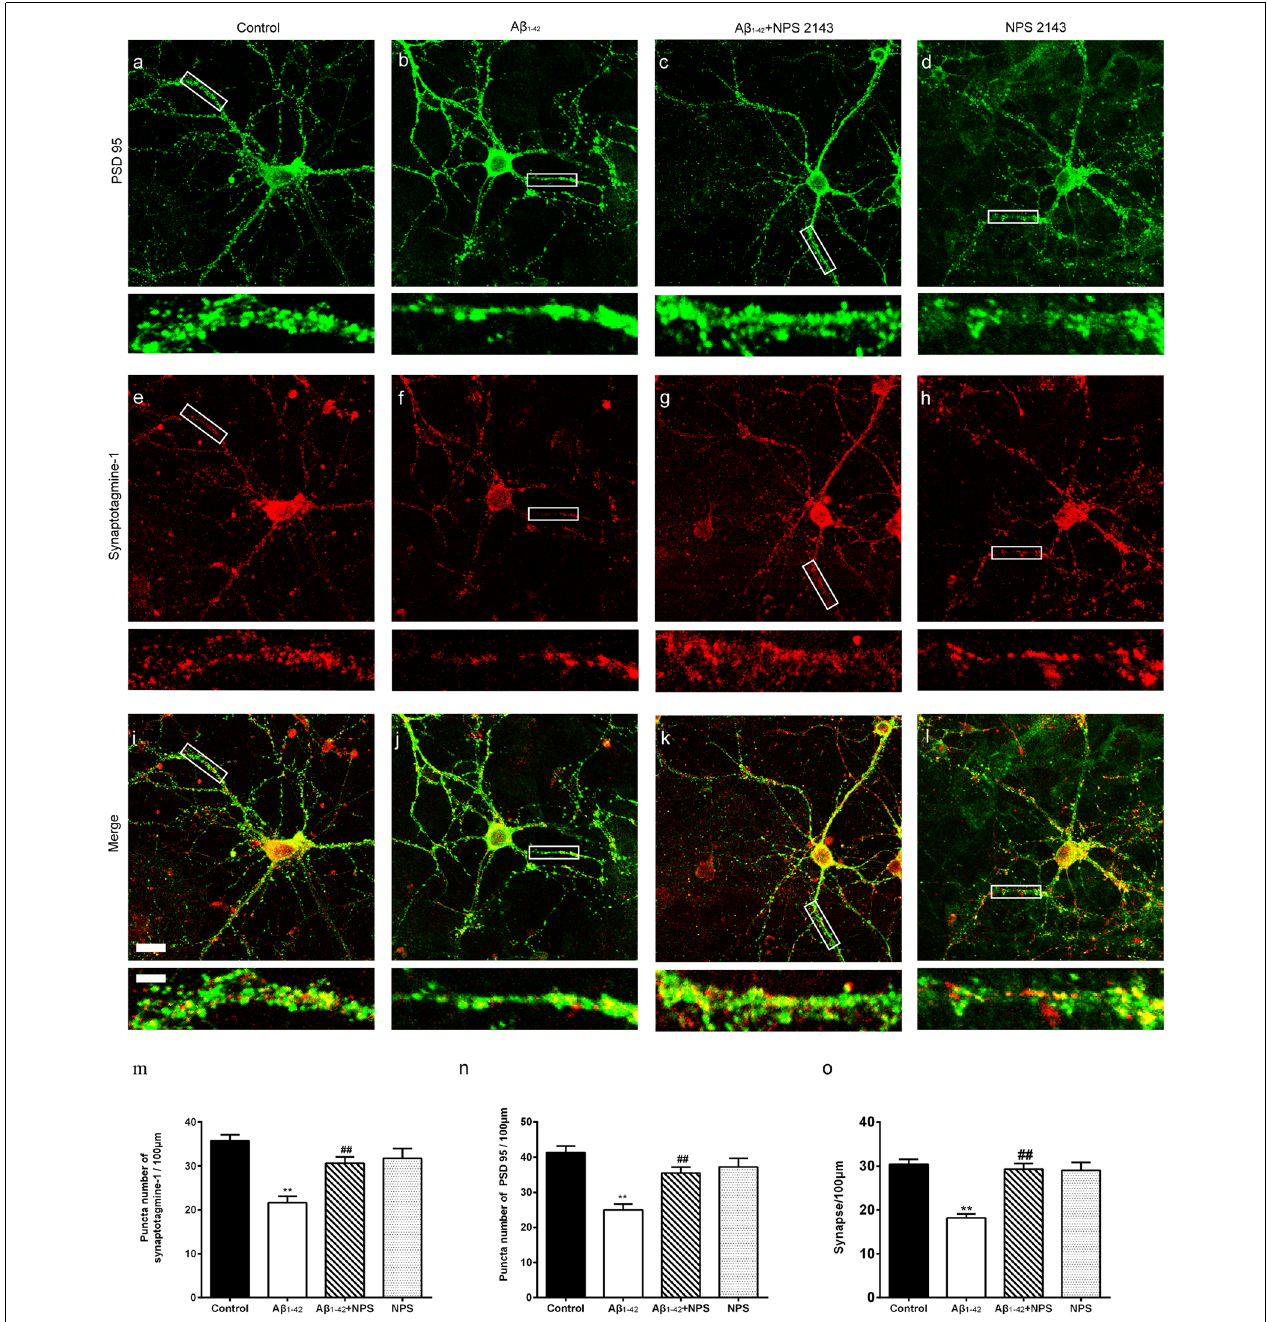
FIGURE 4 | NPS 2143 prevented hippocampal neurons from soluble A β 1–42 oligomer-induced synapse loss at DIV 14. Synapse was labeled through the co-localization of presynaptic marker synaptotagmine-1(red) and postsynaptic marker PSD 95 (green). Sample figures of the control group (A,E,I) , the 0.5 µ M A β 1–42 group (B,F,J) , the 0.5 µ M A β 1–42 + 0.1 µ M NPS 2143 group (C,G,K) , and the 0.1 µ M NPS 2143 group (D,H,L) . Scale bar 20 µ m and 5 µ m. (M) Quantitative comparison of the numbers of synaptotagmine-1-positive puncta of the four groups. (N) Quantitative comparison of the numbers of PSD 95-positive puncta of different groups. (O) Quantitative comparison of the density of dendritic synapse of the four groups. ** P < 0.01 vs. control group, ## P < 0.01 vs. A β 1–42 oligomer-treated group. Values represent mean ± SEM, n = 24–34 neurons from three independent primary cell culture preparations.